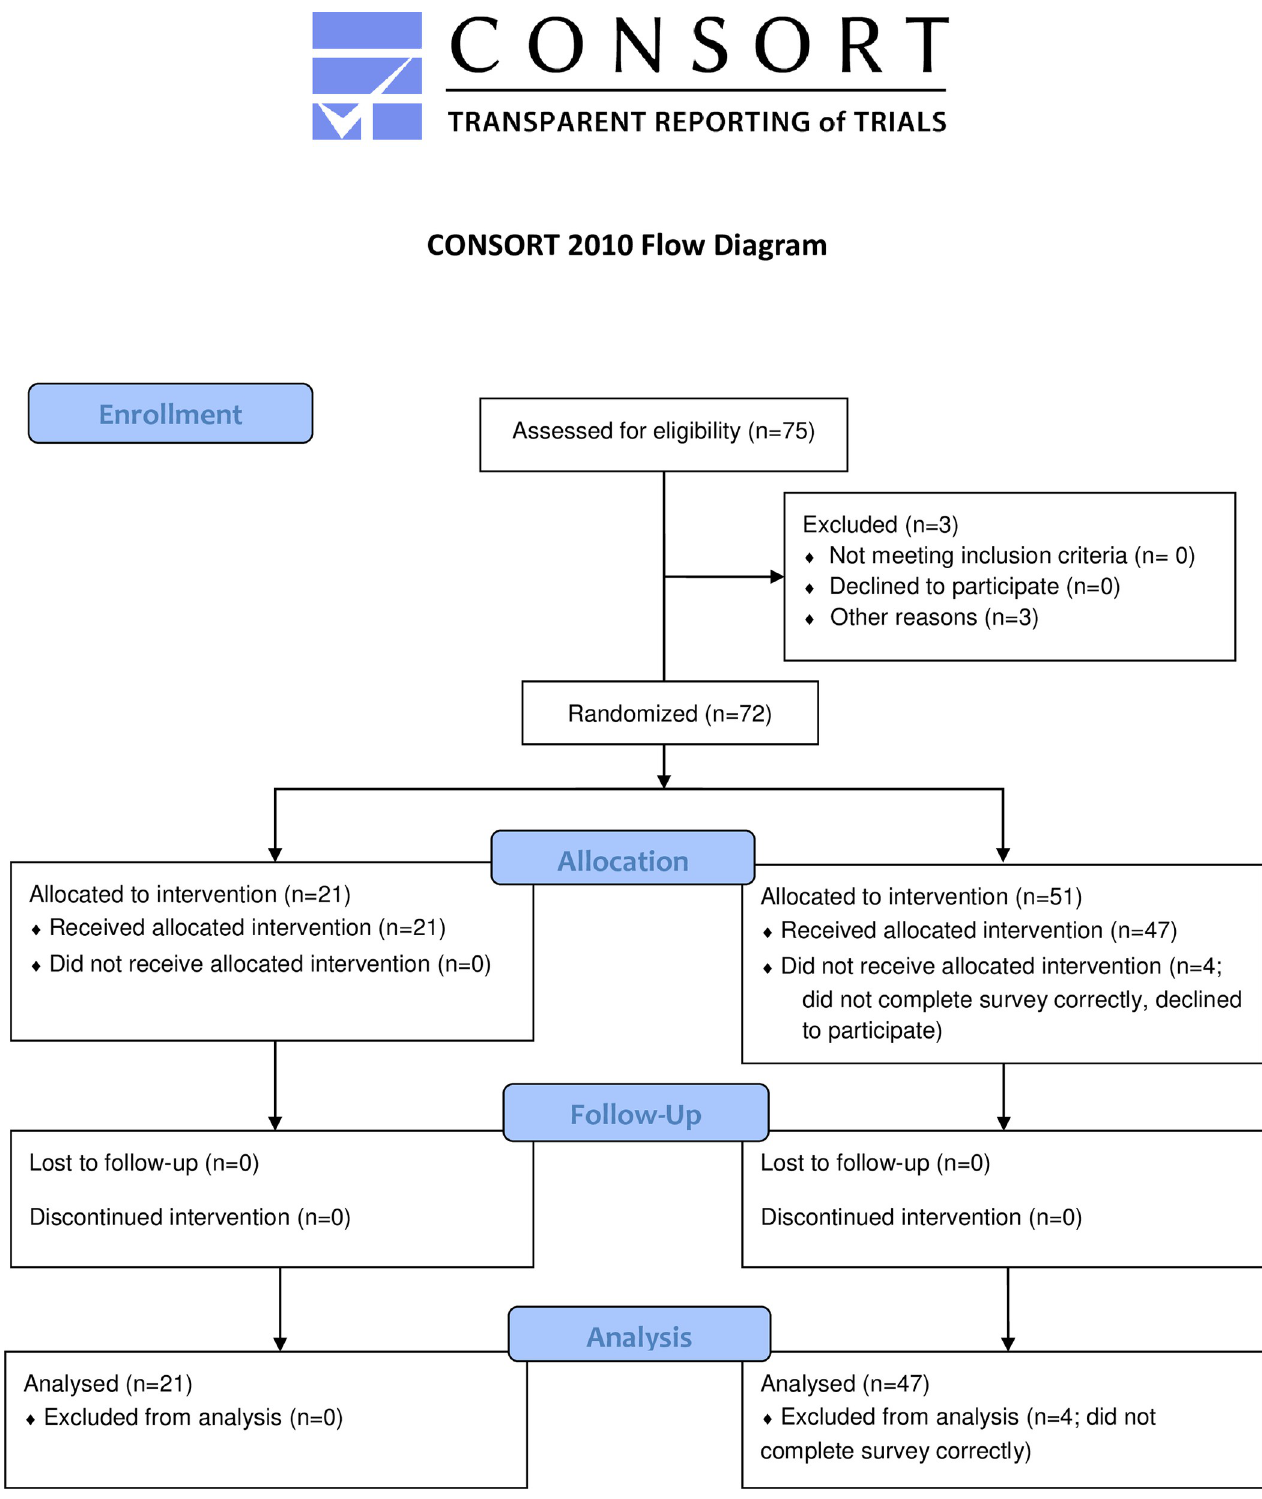
Fig 1. Enrolment, intervention allocation, follow-up, and data analysis.